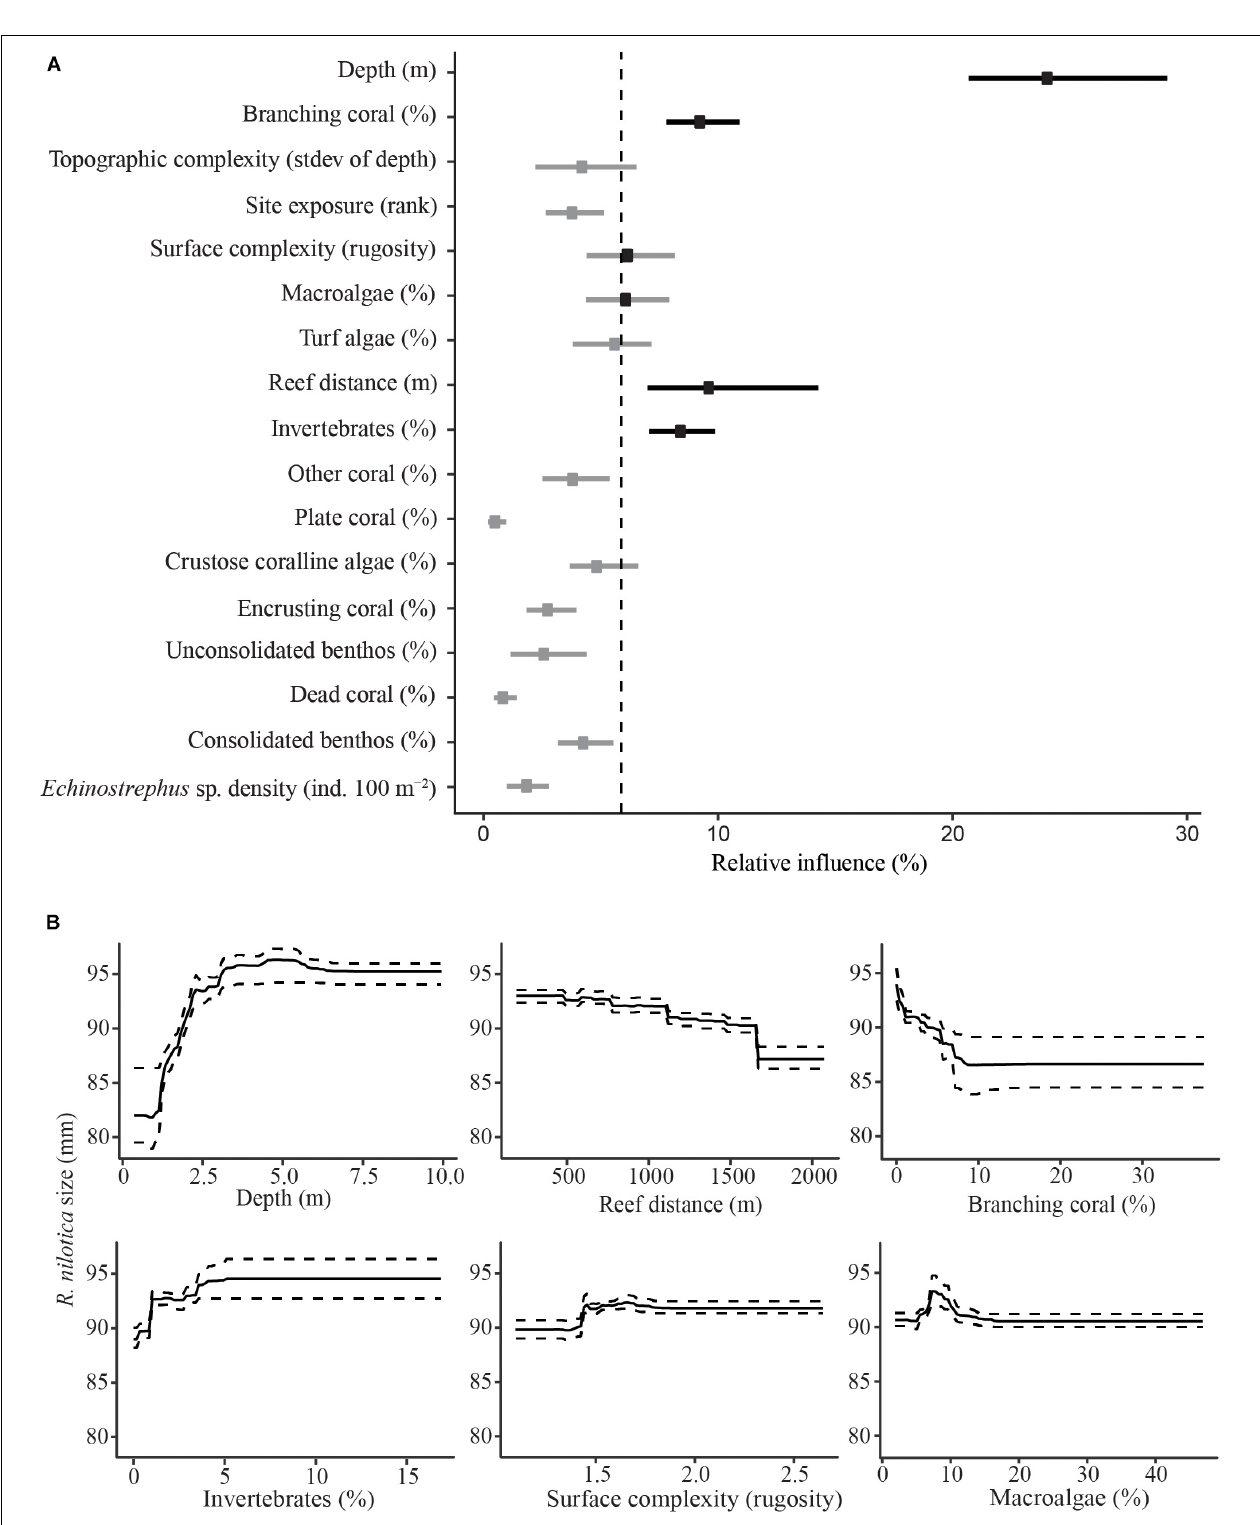
FIGURE 4 | Boosted Regression Tree relative influence plot for predictor variables of R. nilotica size (A) . Dots represent means for each predictor variable and bars represent upper and lower 95% quantiles. The vertical dashed line represents the significance threshold (100/17), variables exceeding the threshold are in black and those that do not are gray. Partial effects for significant predictor variables against R. nilotica size (B) . Solid lines represent means for each predictor variable and dashed lines represent upper and lower 95% quantiles.